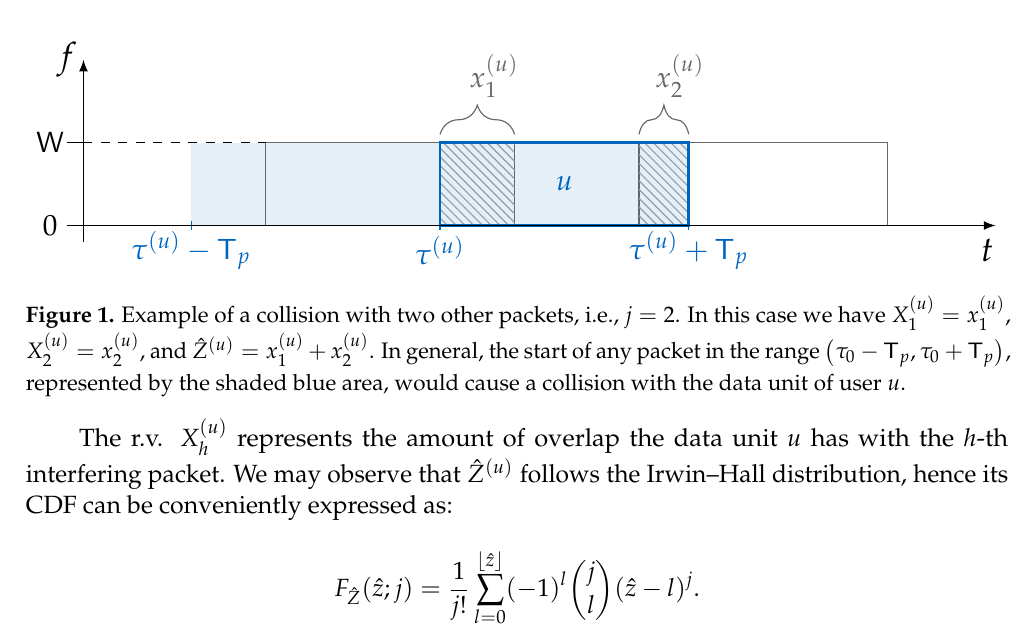
= x ( u ) , 1 1 (cid:0) T p , τ 0 + T p (cid:1) , τ 0 −